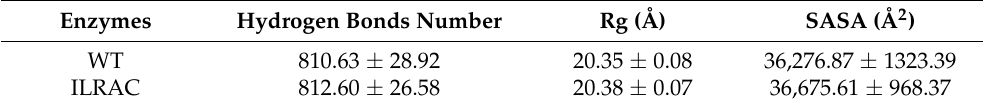
Figure 4. Conformational changes in the wild-type and mutant ILRAC during 100 ns MD (protein– ligand RMSD). Table 3. Hydrogen bonds number, Rg, and SASA values for wild-type and mutant ILRAC.